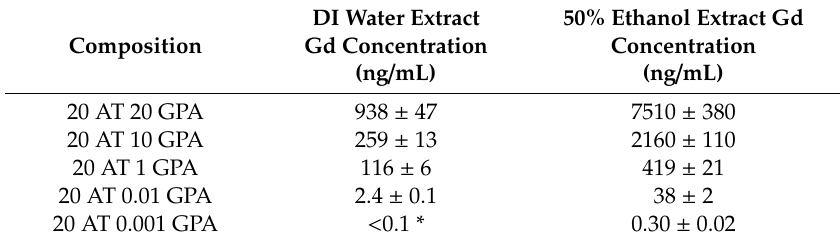
Table 4. ICP-MS results for the ATIPA-GPA foam samples in di ff erent extraction vehicles. Results are displayed as Gd concentration ± uncertainty.